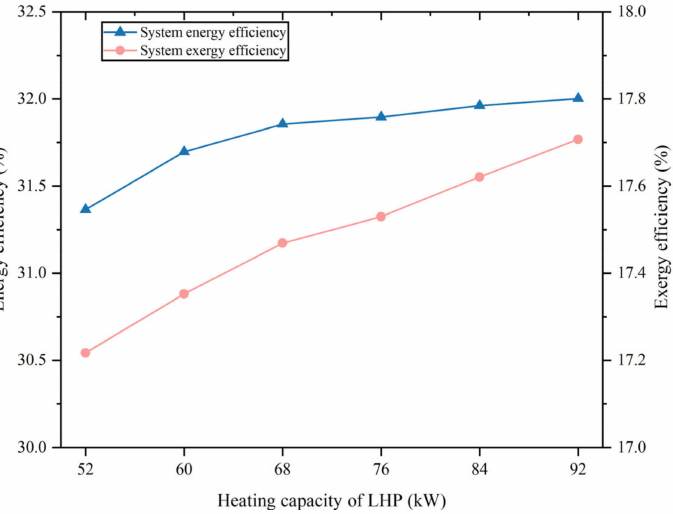
Figure 24. Variation between system energy and exergy efficiency with different capacities of